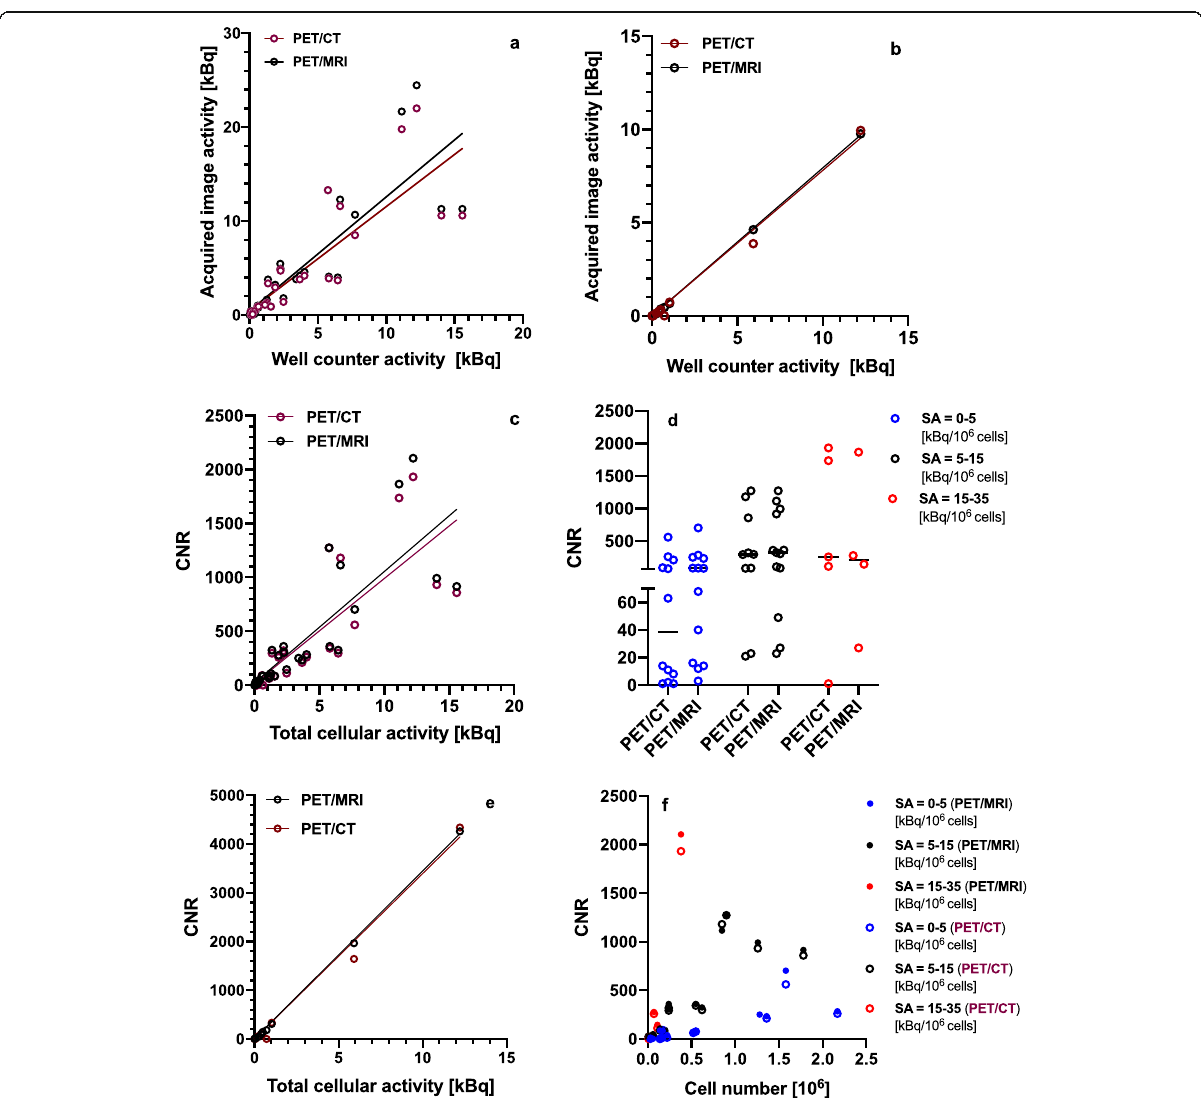
Fig. 3 Pearson correlation between the total cell-associated activity [kBq] measured in the well counter and on PET images for a 6-well plates and b 3 × 3 cubic-well plate. c Pearson correlation of PET/CT and PET/MRI CNR vs. total cellular activity [kBq] for 6-well plates. d Individual value plot and median of CNR per specific activity category for both PET/CT and PET/MRI for 6-well plates. e Pearson correlation of PET/CT and PET/MRI CNR vs. total cellular activity [kBq] for 3 × 3 cubic-well plate. f Scatter plot of PET/CT and PET/MRI well CNR vs. cell number per specific activity category. CNR: contrast-to-noise